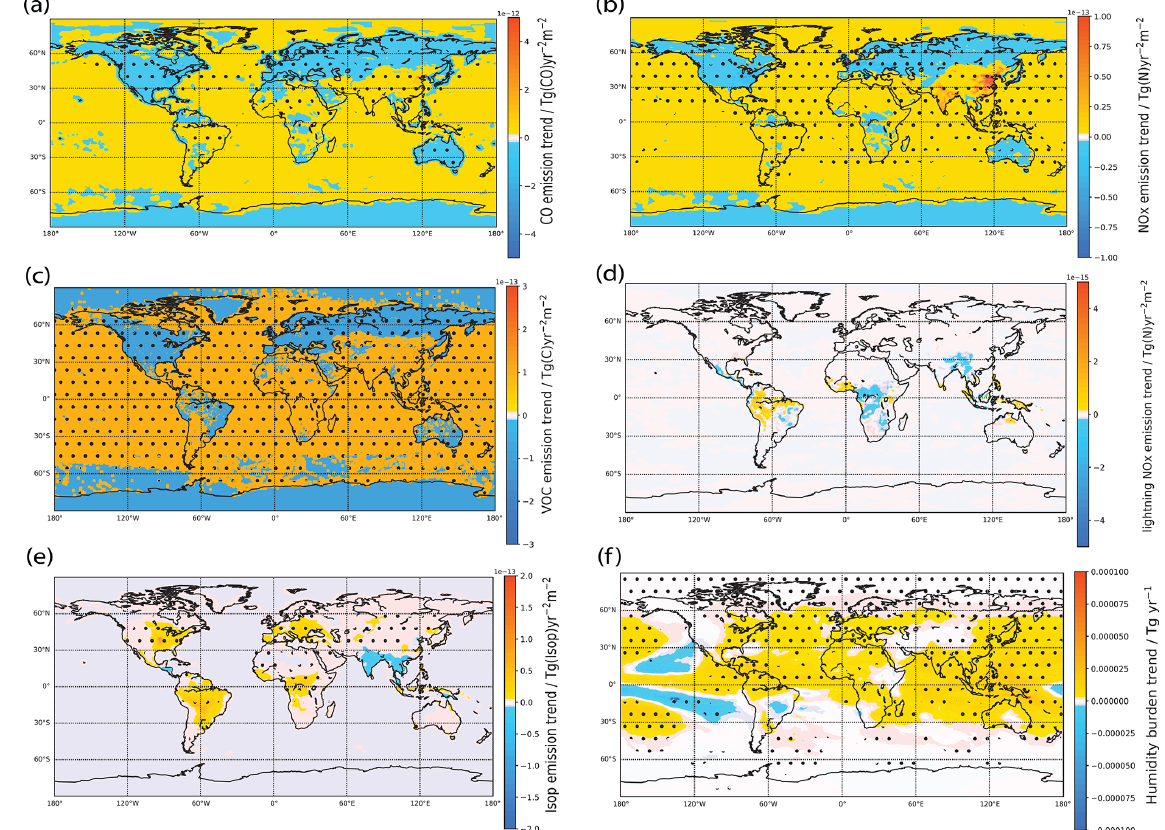
Figure 4. Spatial trends of (a) non-lightning NO x , (b) CO, (c) NMVOC, (d) lightning NO x , (e) biogenic isoprene emissions and (f) humidity from 1980–2014. Trends and stippling are as per Fig. 3, except for panels (a) , (b) and (d) , where we additionally remove stippling when the trend is below 10 − 16 Tgyr − 2 m − 2 . [OH] changes in the NO x run are positively correlated with the changes in non-lightning NO x emissions (seen in panel a ), which itself matches the Base run changes very well. Meanwhile, the CO run produces changes in [OH] that are negatively correlated with the changes in CO emissions (seen in panel b ). The large negative trend over central Africa results not only from contributions from increasing CH 4 concentrations and increasing NMVOC emissions (seen in panel c ), which tend to reduce [OH] by increasing chemical loss, but also from meteorology-related factors, such as lightning NO x as seen in panel (d) and isoprene emissions as seen in panel (e) . From panel (f) , we see the water vapor burden has increased significantly in most regions, which tends to locally increase OH chemical production. These competing local effects on [OH] from meteorology-driven factors accounts for the absence of a globally averaged [OH] trend contribution from